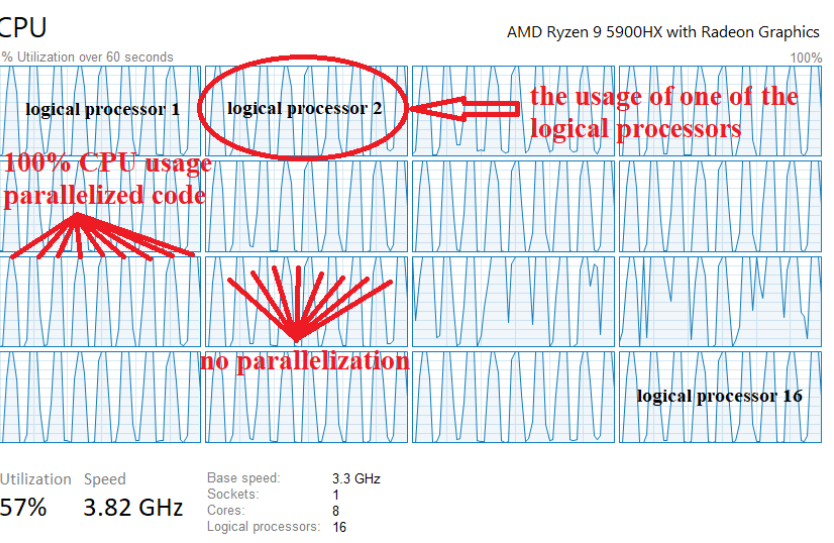
Figure 28. Logical processors usage in multithread